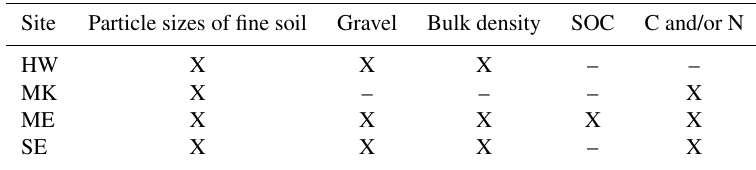
Table 8. Availability of soil information per site. C and/or N: both carbon and nitrogen content is not always available. Due to the absence of carbonates, C content is expected to equal soil organic carbon